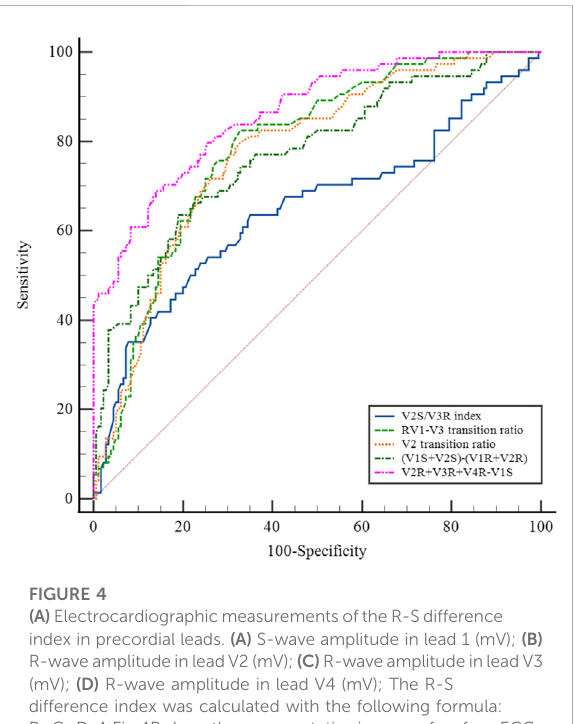
FIGURE 5 Comparison of the R-S difference index in the